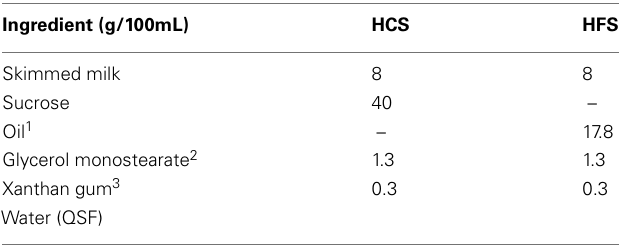
Table 2 | Composition of the high-fat (HFS) and high-carbohydrate (HCS) solutions used for the determination of dietary preferences through the two-bottle choice